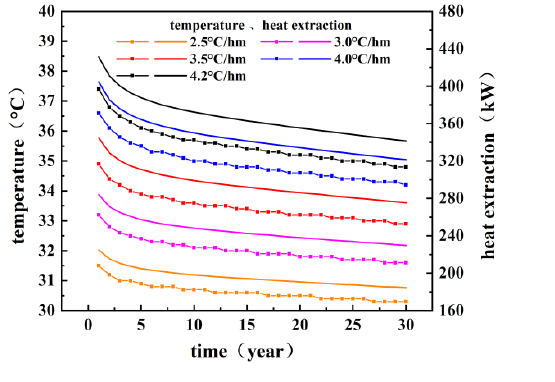
8 of 17 Table 2. Numerical simulation strategy. Well